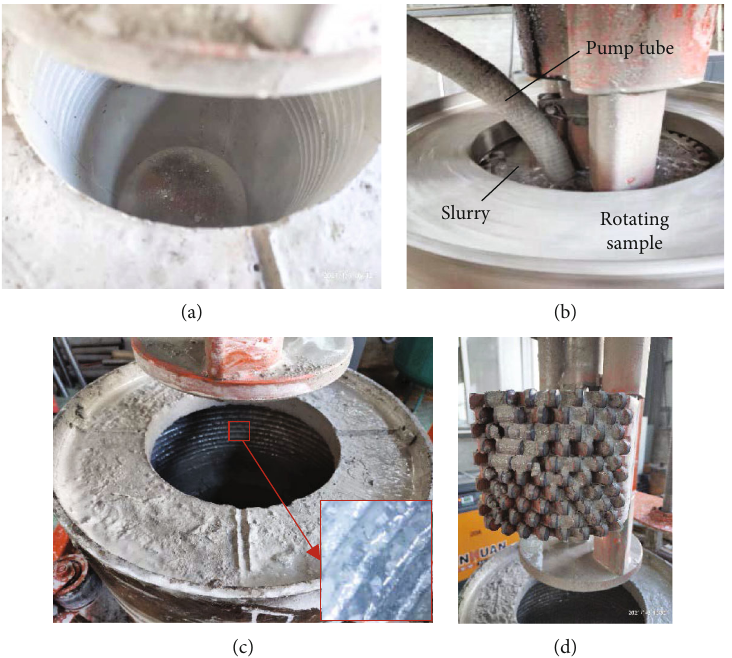
Figure 11: (a) Sample before reaming. (b) Reaming the sample. (c) Inside of reamed sample. (d) Bionic blade after